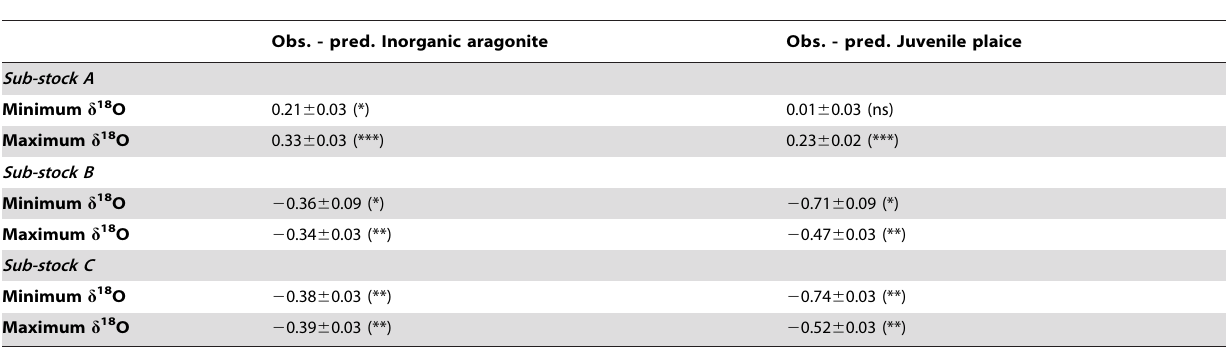
Table 3. Average ( 6 SE) differences between measured and predicted extreme d 18 O values (in % ) obtained for the 3 sub-stocks when using either the fractionation equation for inorganic aragonite [2] or that for juvenile plaice reared under controlled conditions